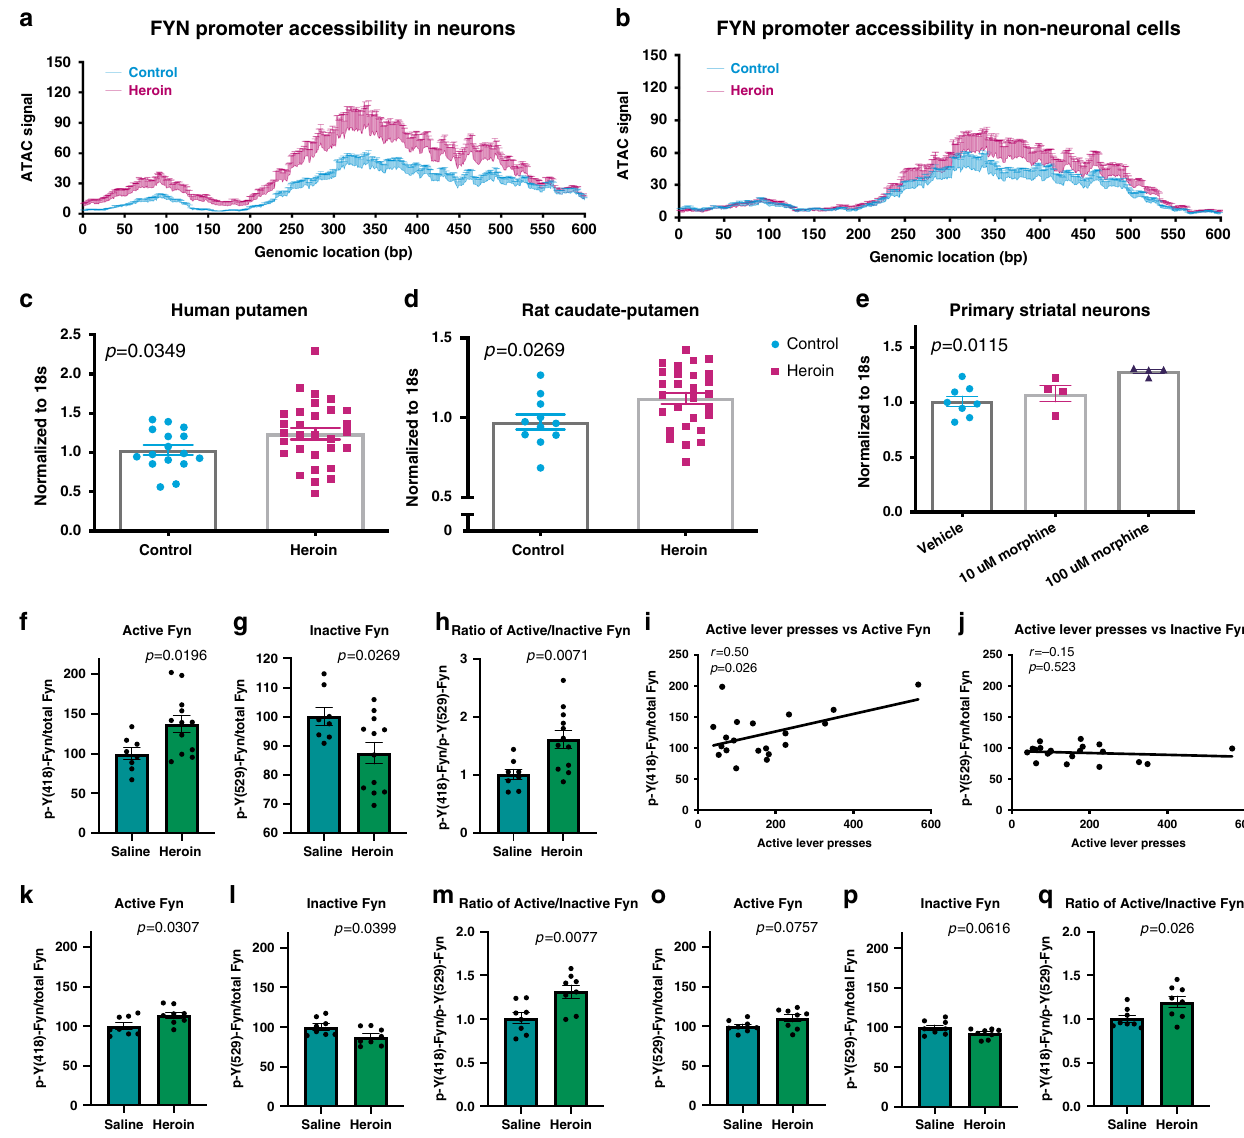
Fig. 4 Heroin leads to enhanced chromatin accessibility, transcription, and activity of FYN. a , b ATAC-seq signal over a 600 bp region (chr6:112194332 – 112194931) overlapping the transcription start site of FYN in NeuN-positive neuronal ( a ) and NeuN-negative non-neuronal ( b ) cell populations. Accessibility of this region is markedly increased by heroin, especially in neuronal cells. c FYN mRNA levels were increased in the putamen of human heroin users compared to matched controls ( n = 30 heroin users, n = 16 controls, Student ’ s t -test, t 44 = 1.859, p = 0.0349). d Fyn mRNA levels were increased in the caudate-putamen of heroin self-administering rats ( n = 12/28 control/heroin, Student ’ s t -test, t 37 = 2.305, p = 0.0269). e Fyn mRNA levels were increased in primary striatal cells treated with morphine (one-way ANOVA F 2,13 = 6.419, p = 0.0115; signi fi cant increase observed with 100 µ M morphine, Student ’ s t -test t 10 = 3.785, p = 0.0036). f Active p(Y418)-Fyn levels were increased in the dorsal striatum of heroin self-administering rats 24 h after the last session ( n = 8/12 control/heroin, Student ’ s t -test, t 18 = 2.563, p = 0.0196). g Inactive p(Y529)-Fyn levels were decreased in the same animals ( n = 8/12 control/heroin, Student ’ s t -test, t 18 = 2.411, p = 0.0268). h Ratio of active/inactive p-Fyn was signi fi cantly increased in the same animals ( n = 8/12 control/heroin, Student ’ s t -test, t 18 = 3.037, p = 0.0071). i , j Active (I; linear regression, F 1,18 = 5.854, r = 0.50, p = 0.0263) but not inactive (J; linear regression, F 1,18 = 0.4255, r = − 0.15, p = 0.5225) dorsal striatal p-Fyn correlated positively with active lever pressing. k Active p(Y418)-Fyn levels were increased in the dorsal striatum of heroin self-administering rats 2 weeks after the last session ( n = 8/group, Student ’ s t -test, t 14 = 2.403, p = 0.0307). l Inactive p(Y529)-Fyn levels were decreased in the same animals ( n = 8/group, Student ’ s t -test, t 14 = 2.265, p = 0.0399). m Ratio of active/ inactive p-Fyn was signi fi cantly increased in the same animals ( n = 8/group, Student ’ s t -test, t 14 = 3.106, p = 0.0077). n Active p(Y418)-Fyn levels showed an increasing trend ( n = 8/group, Student ’ s t -test, t 14 = 1.918, p = 0.0757) in the dorsal striatum of naive rats injected with a single dose of 1 mg/kg heroin. o Inactive p(Y529)-Fyn levels showed a decreasing trend in the same animals ( n = 8/group, Student ’ s t -test, t 14 = 2.032, p = 0.0616). p Ratio of active/ inactive p-Fyn was increased in the same animals ( n = 8/group, Student ’ s t -test, t 14 = 2.492, p = 0.0259). Data are represented as mean ± SEM (normalized to saline group in f – p ). Source data are provided as a Source Data fi